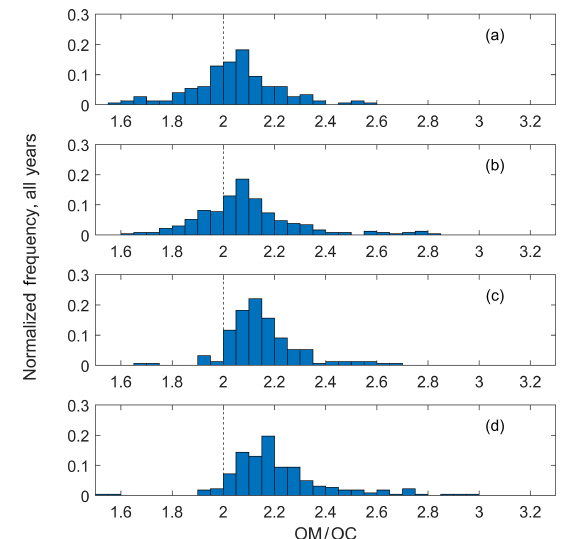
Figure 5. Histograms of OM / OC ratios predicted using functional group measurements, separated into (a) urban (BHM and JST) Jan- uary, (b) rural (CTR, YRK, and OLF) January, (c) urban July, and (d) rural July. January is used to approximate winter; July is used to approximate